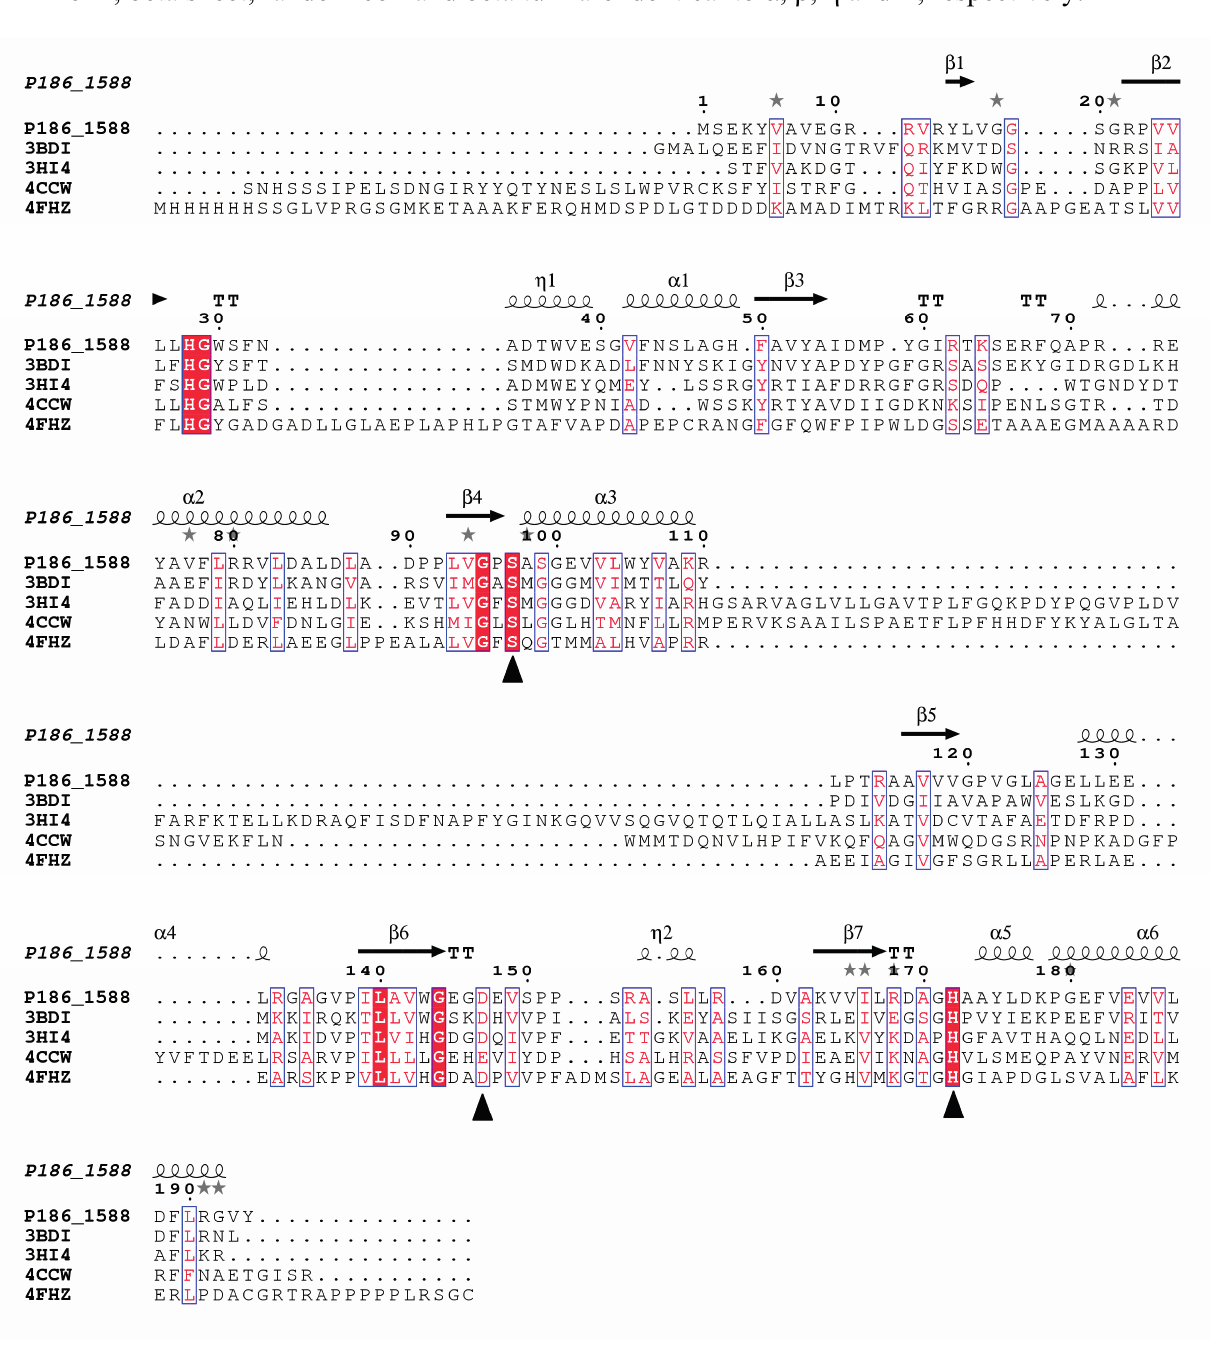
Figure 1. Multiple sequence alignment between P186_1588 and other closely related esterases: 3BDI, an uncharacterized carboxylesterase from Thermoplasma acidophilum ; 3HI4, a carboxylesterase from Pseudomonas fluorenscens ; 4CCW, a carboxylesterase from Bacillus subtilis ; 4FHZ: a carboxylesterase from Rhodobacter sphaeroides . The catalytic triad of P186_1588 (Ser 97 , Asp 147 , and His 172 ) is marked with filled triangles ( ▲ ). The alpha helix, beta sheet, random coil and beta turn are identical to α , β , η and T,